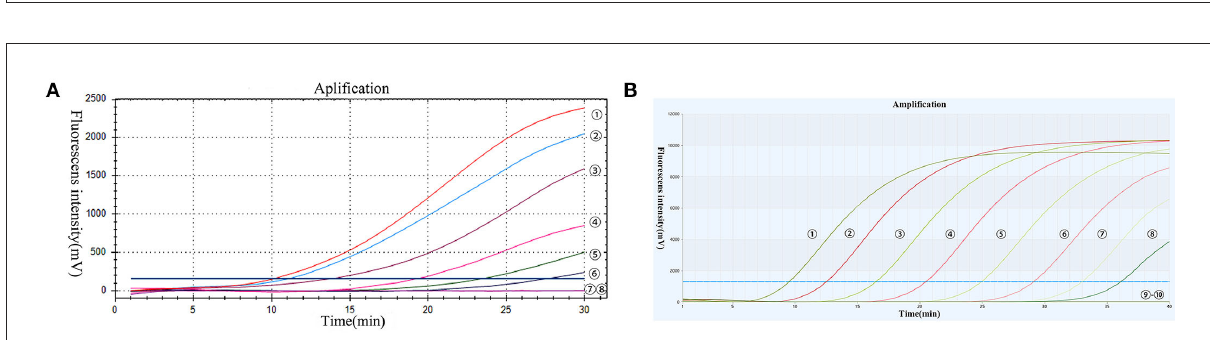
FIGURE3 (A) The results of RT-RAA sensitivity analysis: RT-RAA PoRVA plasmid as standard, ‹ - † : 1 × 10 5 -1 × 10 − 1 copies per reaction sequentially; ‡ : negative control. (B) The results of TaqMan probe-based RT-qPCR sensitivity analysis: TaqMan probe-based RT-qPCR PoRVA plasmid